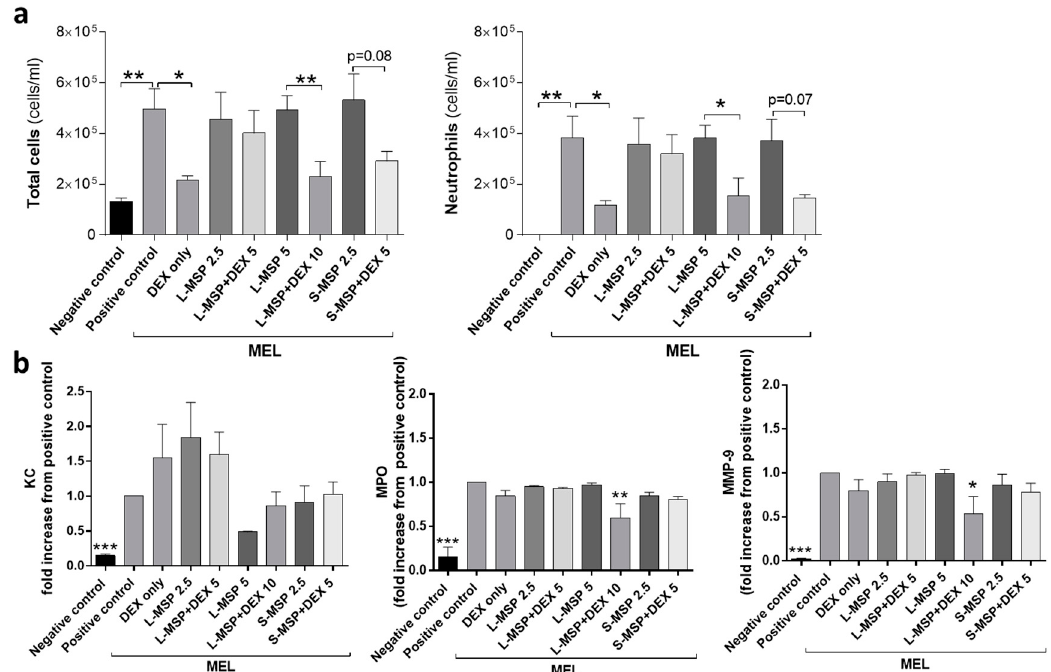
Figure 2. ( a ) Total leukocytes and the total number of neutrophils in bronchoalveolar fluid (BALF) and ( b ) analysis of (keratinocyte chemoattractant (KC), Mouse Myeloperoxidase (MPO), and Matrix metalloproteinase-9 (MMP-9)) in BALF from mice exposed to melphalan (MEL). Values indicate means ± SEM, * p < 0.05, ** p < 0.01, *** p < 0.001 compared to control groups. MSP—mesoporous silica particle (L—large; S—small), DEX—dexamethasone. Positive control: HEPES buffer administered to mice exposed to MEL/LPS; negative control: HEPES buffer administered to healthy mice; DEX only: 5 mg/mL (free DEX/HEPES buffer). The numbers on the x-axis denote mg/mL (particles/HEPES buffer). Each bar represents a group of n = 6 animals.